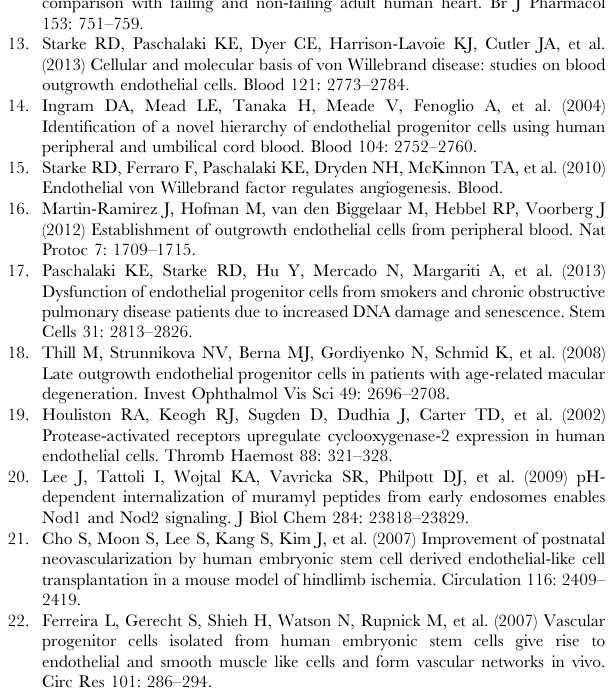
Figure S1 Effect of NOD1 siRNA targeting on IL-1 b induced CXCL8 release. CXCL8 release from hESC-EC following 48 hour pre-incubation with non-targeting siRNA (open bars) or NOD1-siRNA (filled bars) and 24 hour treatment with/ without IL-1 b (0.01–0.1 ng/ml). Data are mean 6 SEM (n= 6–8). (TIF) Figure S2 Effect of GSK’214 and GSK’217 on IL-1 b induced CXCL8 release. CXCL8 release from hESC-EC following 30 minute pre-incubation with GSK’214 (300 nM) or GSK’217 (300 nM) and 24 hour treatment with/without IL-1 b (0.1 ng/ml). Data are mean 6 SEM (n= 4). Data were handled as in Figure